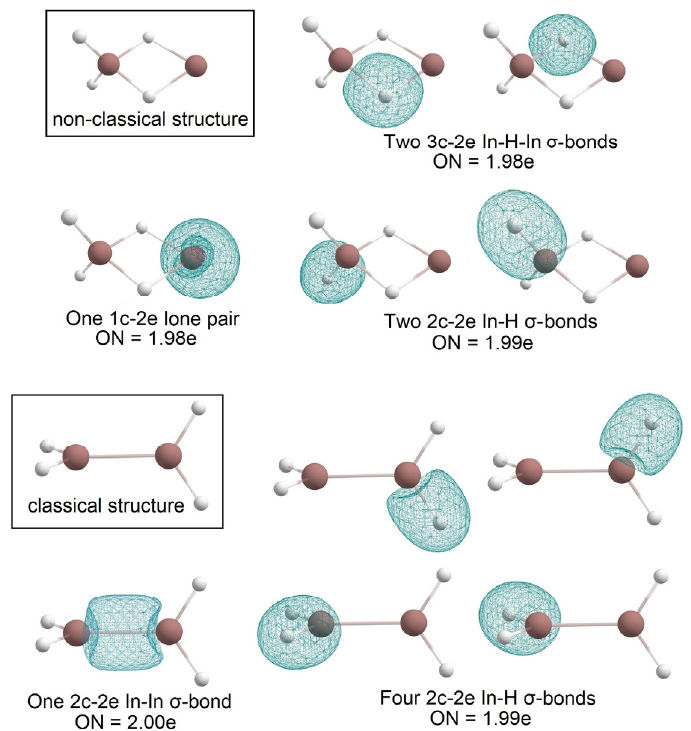
Figure 6. The chemical bonding pattern of In 2 H 4 ― non-classical structure (global minimum) and classical structure obtained by AdNDP classical structure obtained by AdNDP analysis.